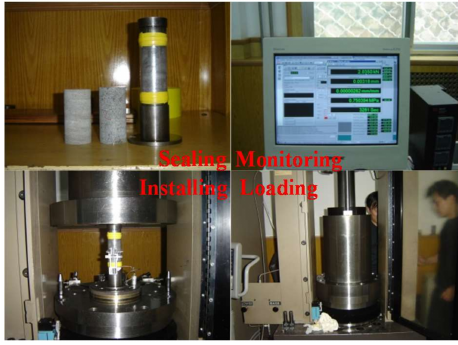
Figure 8. All the procedures used for the experiment.